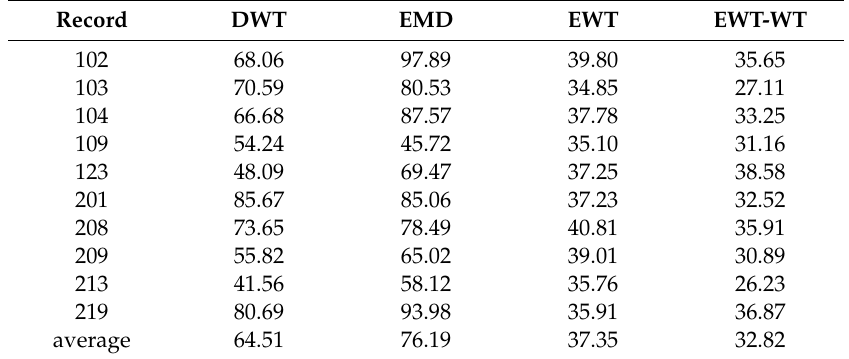
Table 2. The PRD of the denoised ECG signals using DWT, EMD, EWT and EWT-WT methods.